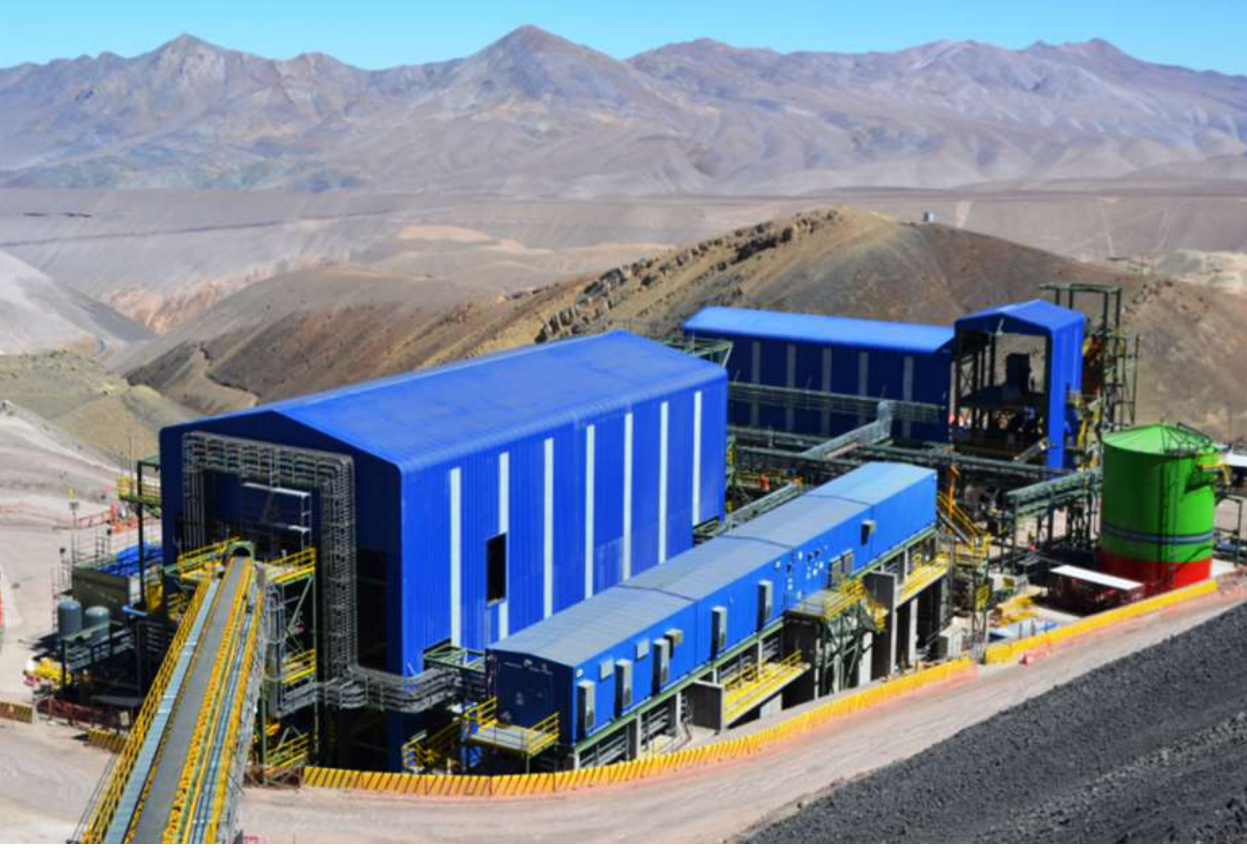
Figure 53. Potrerillos Copper Slag Treatment Plant Facility [18,69].